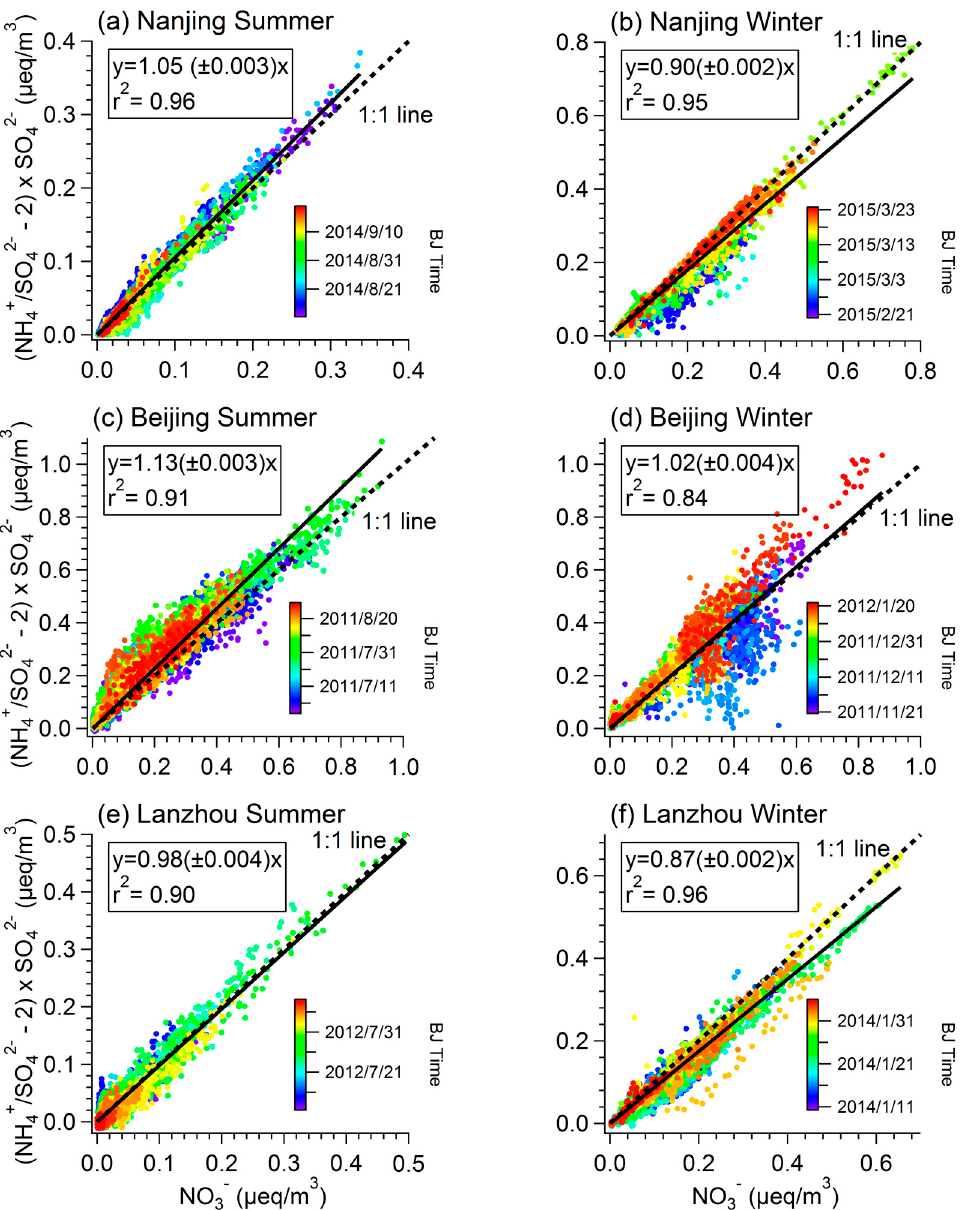
Figure 5. Scatter plots of the molar concentrations of excess NH 4+ relative to (NH 4 ) 2 SO 4 versus NO 3 − (the NH 4+ molar concentrations were the measured NH 4+ molar concentrations minus the amounts used to neutralize HCl): ( a ) Nanjing summer, ( b ) Nanjing winter, ( c ) Beijing summer, ( d ) Beijing winter, ( e ) Lanzhou summer, and ( f ) Lanzhou winter (data pointes were colored by time).